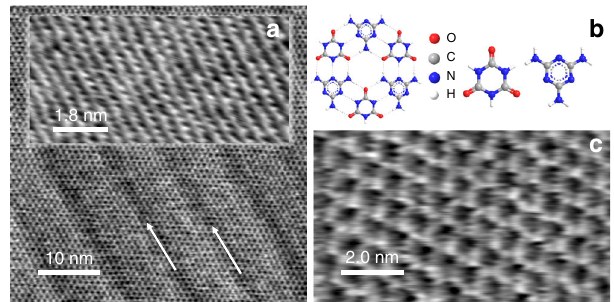
Fig. 3 Melamine cyanurate deposited on the black phosphorus surface. a High-resolution tapping mode AFM scans of melamine cyanurate (CA.M) and the underlying surface of black phosphorus. Arrows show the direction of the CA.M principal axis which is aligned with the BP rows. The CA.M structure was resolved with Multi75Al-G probe using the third harmonic at 1.171 MHz. The image of the surface lattice was acquired in contact mode with an Arrow UHF probe. b Schematic of melamine and cyanuric acid and the CA.M complex. c High-resolution contact mode AFM scan showing